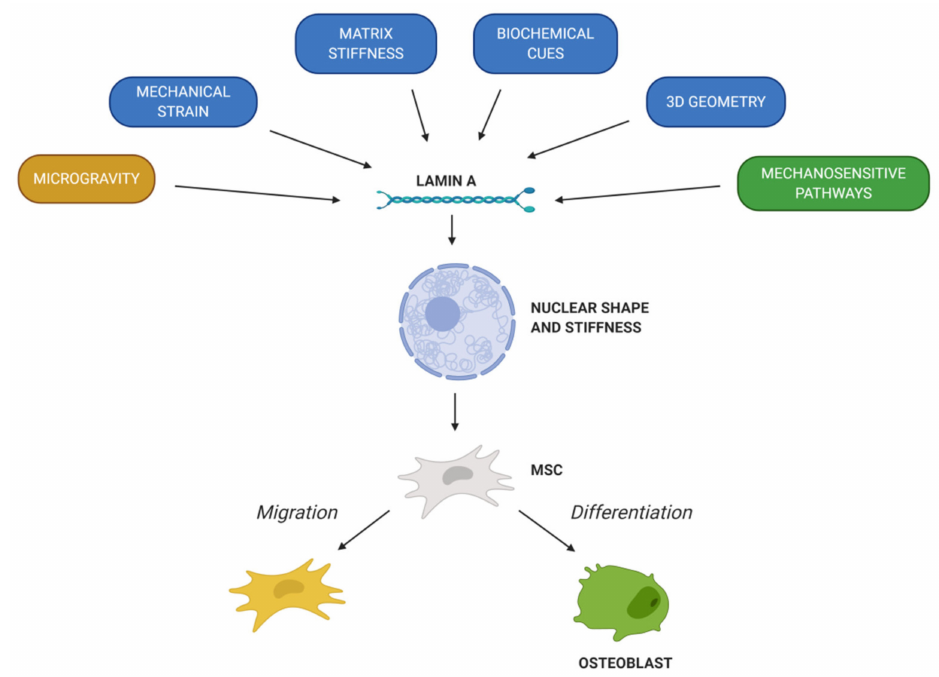
Figure 4. Chemical and mechanical factors that regulate MSCs’ migration and di ff erentiation.